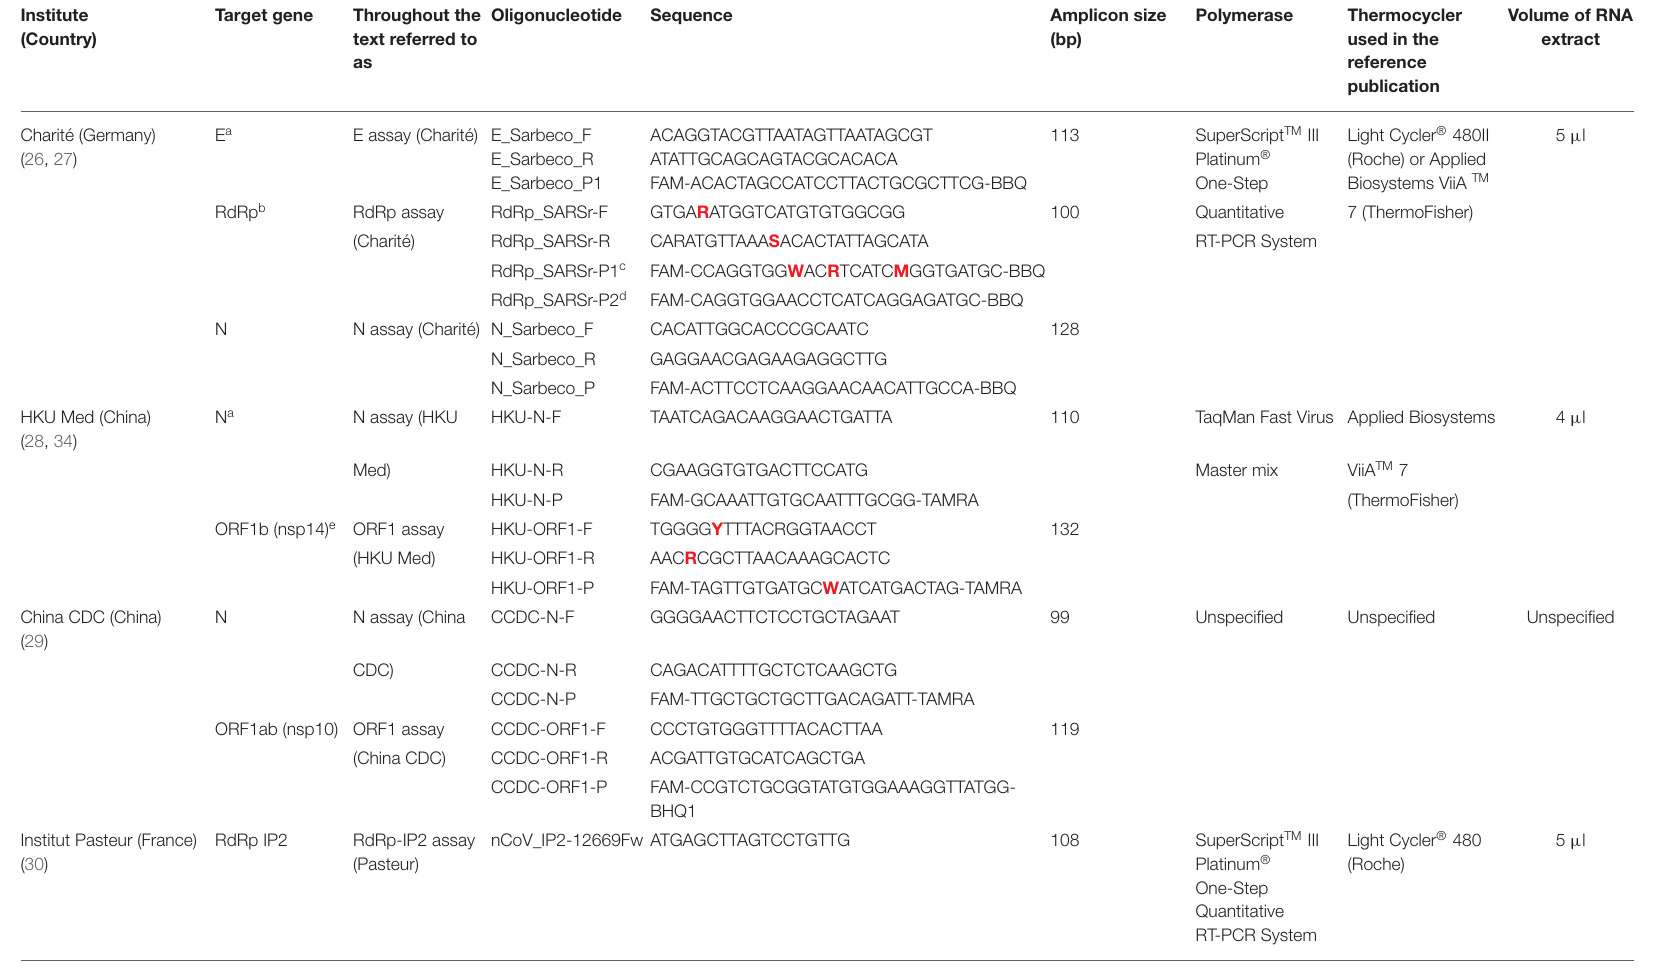
TABLE 2 | Comparison of the different RT-PCR assays protocols published by the World Health Organization. Institute